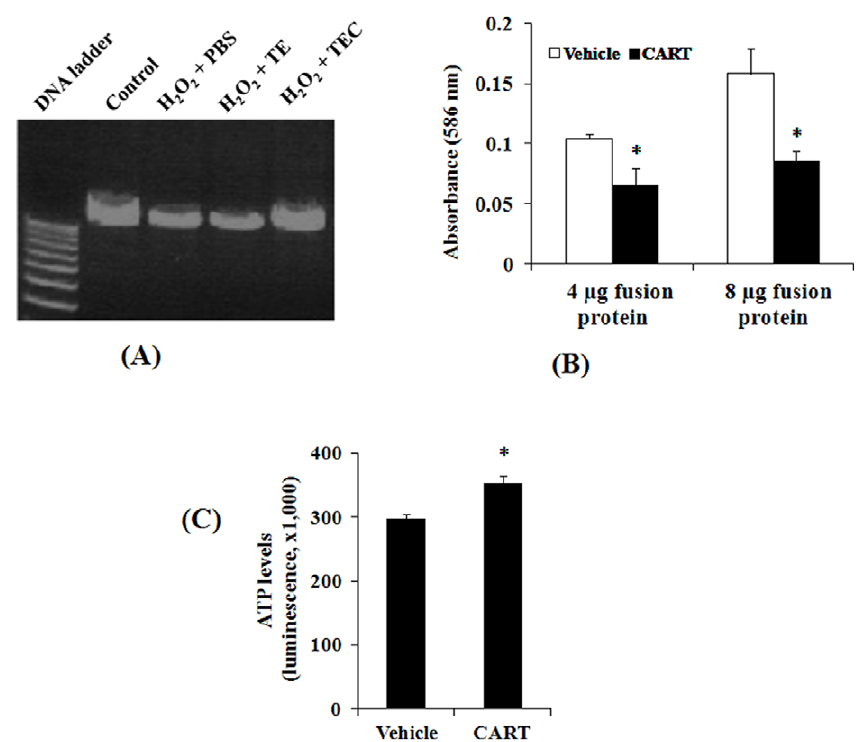
Figure 2. CART antioxidant role in human lymphocytes. ( A ) CART protects mitochondrial DNA damage induced by H 2 O 2 . MtDNAs were amplified by Long PCR as described in Fig. 1. ( B ) CART reduces the levels of lipid peroxidation end products. Protein extracts from lymphocytes treated with 4 and 8 m g TATEGFP-CART were compared to TATEGFP following H 2 O 2 treatment. Total MDA and HNE formation was detected using 4 mg of total cell homogenates as starting material. Absorbance was measured at 586 nm and data are mean 6 SEM of 4 independent experiments. *, P , 0.05, comparing to vehicle group. ( C ) CART preserves cellular ATP production in human lymphocytes. Cultured cells were pretreated with vehicle or CART fusion protein (5 m g/ml) and then treated with H 2 O 2 (0.1 mM) to induce cell death. Cell viability assay performed using a sensitive ATP-based detection method is also an indicator of ATP levels. *, P , 0.01, comparing to vehicle group, n=4.